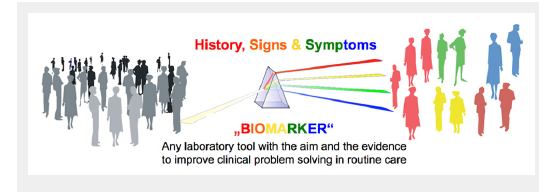
Combined clinical and biomarker assessment for a personalised emergency triage, therapeutic intervention and site of care